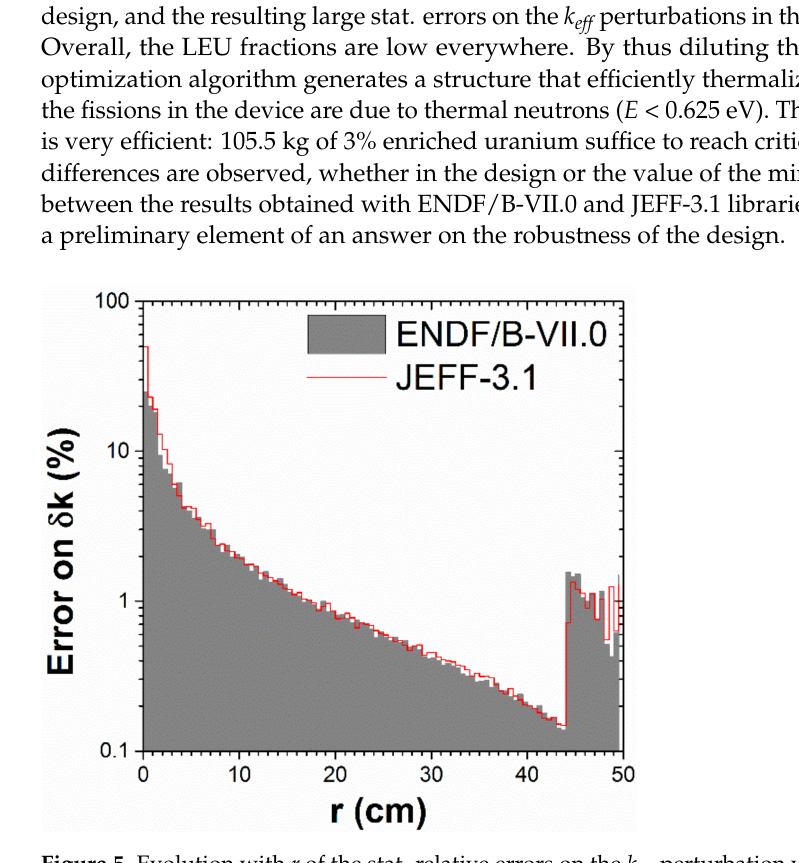
Figure 5. Evolution with r of the stat. relative errors on the k eff perturbation values at n =